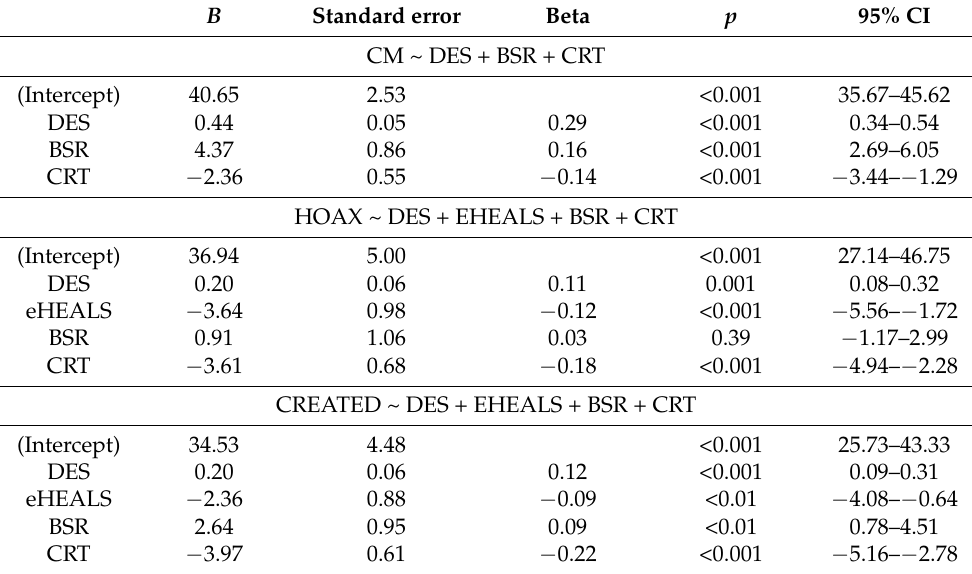
Table 3. Linear regression models of conspiracy mentality (top), the belief that coronavirus is a hoax (middle) and the belief that coronavirus is human-made